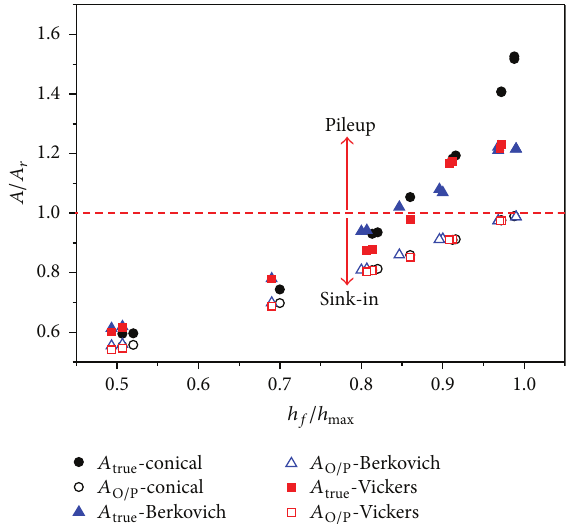
Figure 9: Influence of ℎ 𝑓 /ℎ max on the projected contact area. The projected contact area is normalized by 𝐴 𝑟 , the area calculated by the indenter geometry function. The solid icons stand for the true projected contact area derived from finite element models, while the hollow icons represent the projected contact area calculated by Oliver and Pharr model